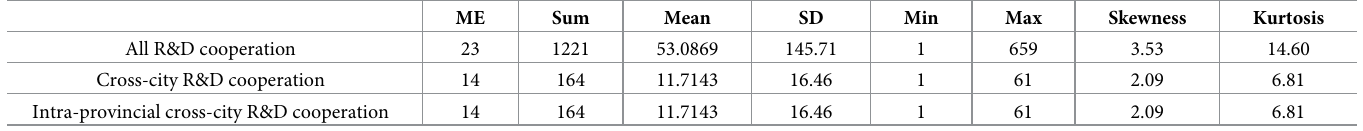
Table 10. Descriptive statistics of the Pearl River Delta